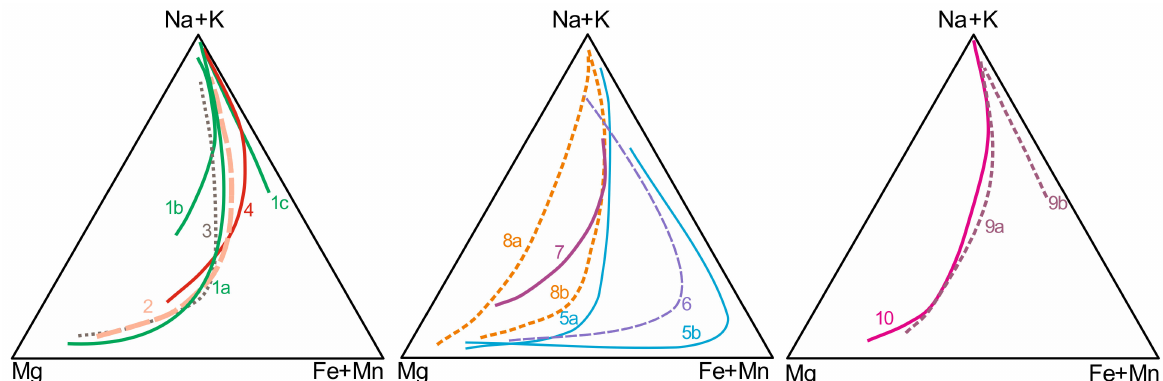
Figure 3. Main clinopyroxene trends of alkaline massifs with agpaitic rocks in southeastern Brazil. 1. Poços de Caldas [14,73]; a. main trend of both nepheline syenites and phonolites, b. lujavrite and khibinite types, c. eudialyte-bearing phonolites and nepheline syenites; 2. Itatiaia [15,40]; 3. Passa Quatro [19,20]; 4. Bom Repouso [21]; 5. B ú zios Island [65]; 6. Monte de Trigo Island [62]; 7. Itapirapu ã [27]; 8. Lages [30]; 9. Cerro Siete Cabezas [32]; 10. Cerro Boggiani